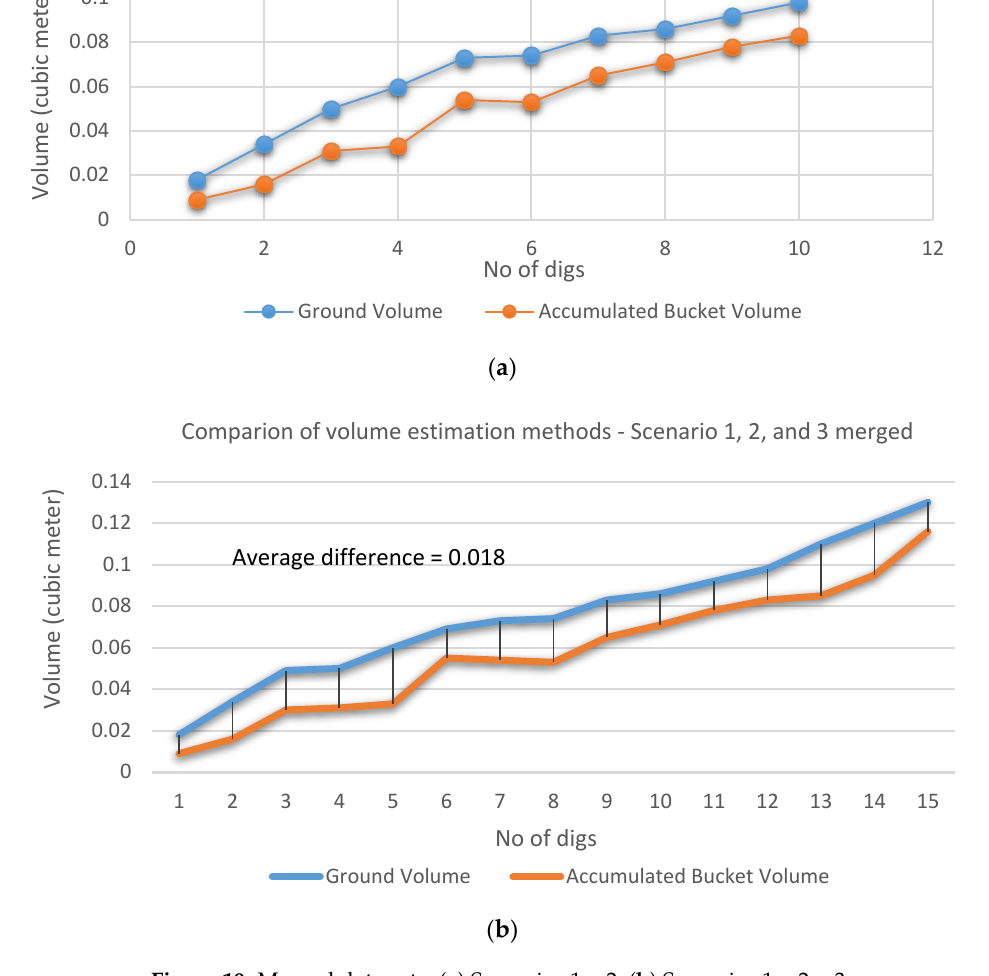
Figure 19. Merged data sets: ( a ) Scenarios 1 + 2; ( b ) Scenarios 1 + 2 + 3.